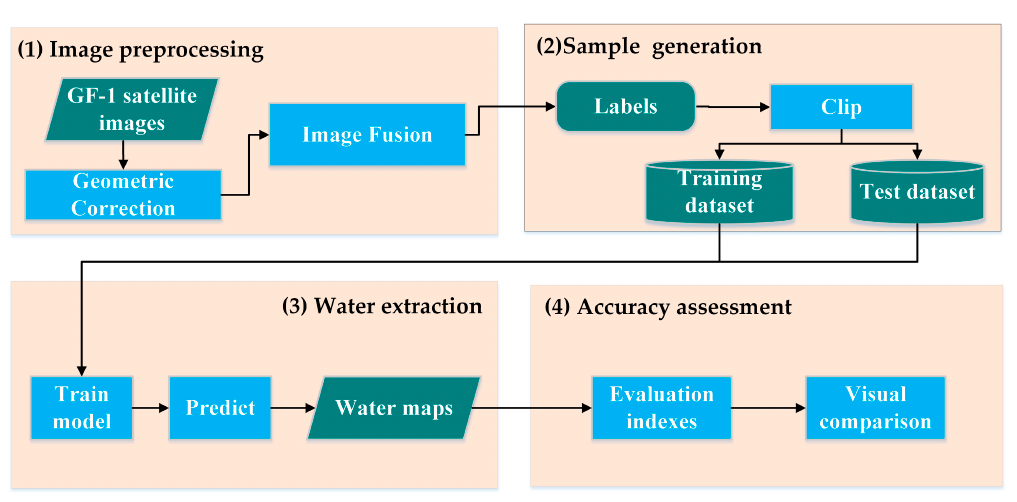
Figure 2. Flowchart of this study.